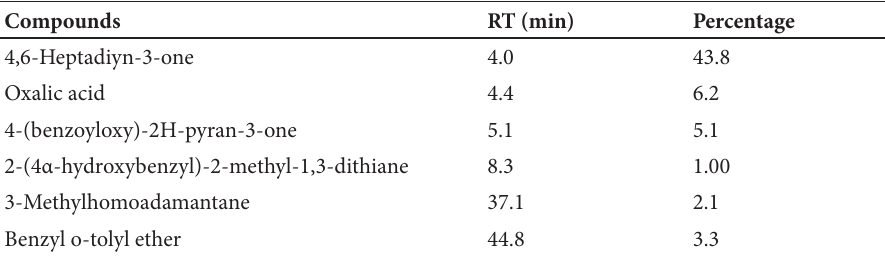
Table 1. The main compounds of essential oil of C. pterocaulos